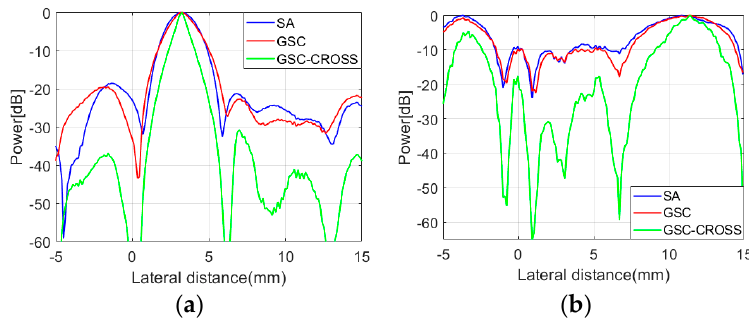
Figure 8. Lateral variation of point at ( a ) z = 75.6 mm; ( b ) z = 88 mm.